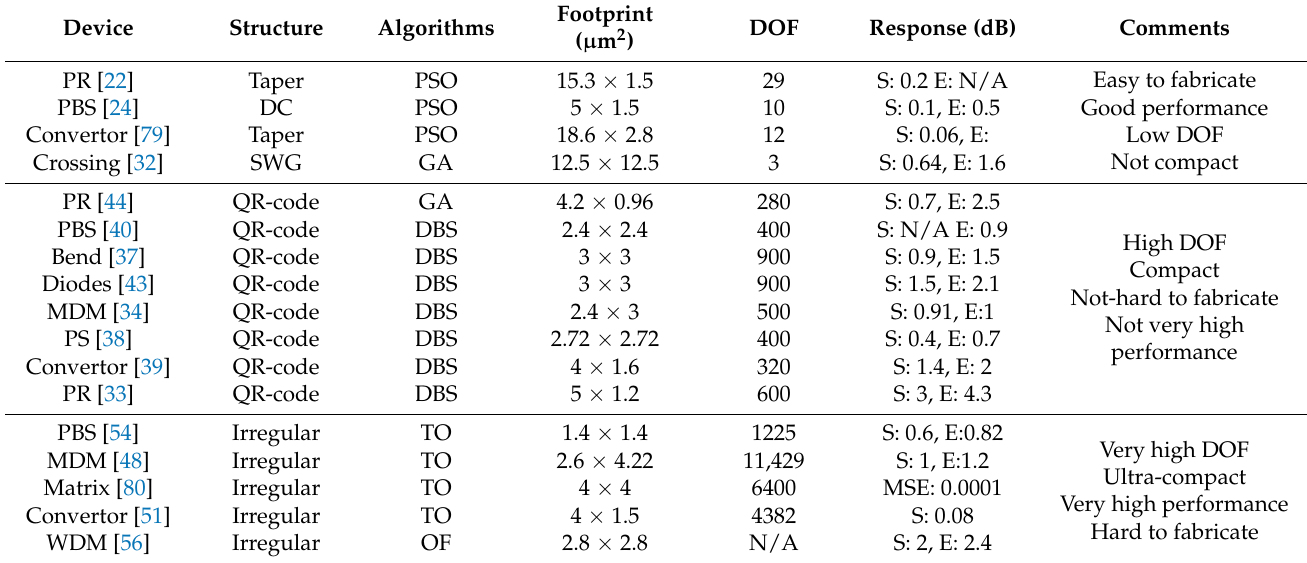
Table 1. Examples of silicon photonic devices designed using iterative optimization algorithms.